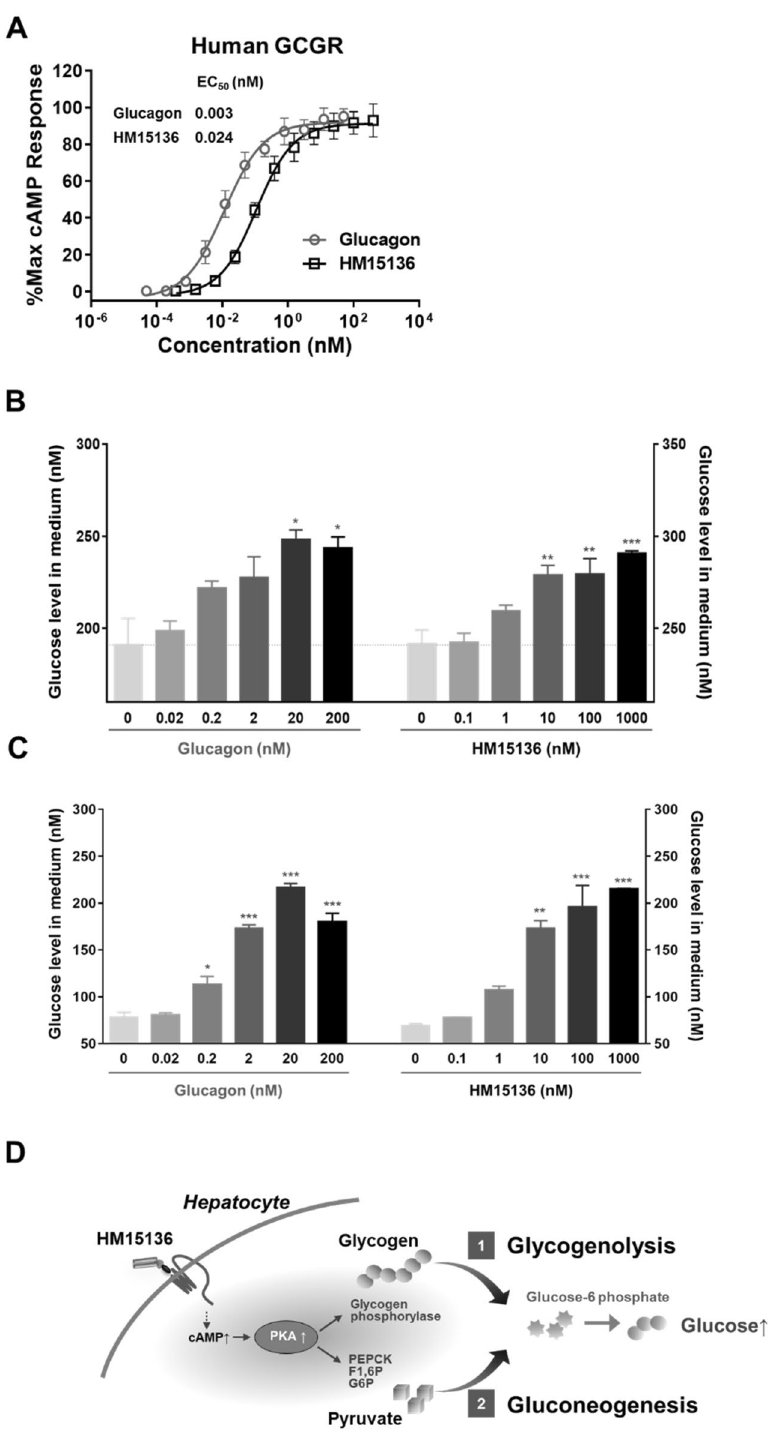
Figure 2. HM15136 stimulates GCCR and increases cAMP levels. ( A ) HM15136 induced a dose-dependent increase in intracellular cAMP levels in hGCGR/CHO cells. Symbols denote native glucagon (open circle) and HM15136 (open square). The concentration of individual test agents ranged from 0.0002 to 194.4 nM (for native glucagon) and from 0.0015 to 1555.2 nM (for HM15136). ( B,C ) Glucose production in rat primary hepatocyte treated with either HM15136 or native glucagon for 30 min ( B , for glycogenolysis) and 6 h ( C , for gluconeogenesis). Isolated hepatocytes were incubated with insulin to promote glycogen production and then, treated with HM15136 for 30 min to induce glycogenolysis. For gluconeogenesis, serum-starved hepatocytes were treated with HM15136 for 6 h in the presence of pyruvate and lactate. After treatment, the glucose level in the collected medium was determined via a GOPOD assay. Results represent mean ± S.D. of duplicate assessments. *p < 0.05, **p < 0.01, ***p < 0.001 vs 0 nM. ( D ) Mechanism of HM15136 for elevation of glucose blood